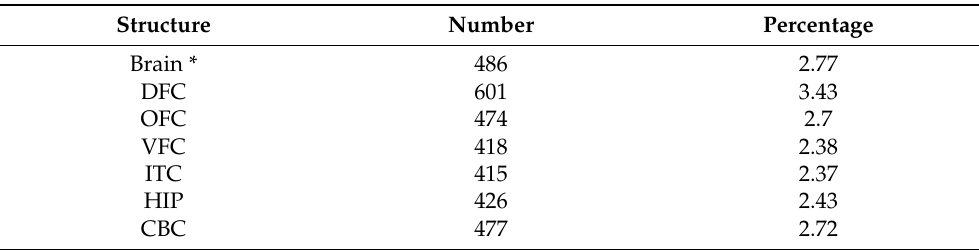
Table 2. Number and percentage of coding protein genes per brain structure which are over-expressed in Down syndrome patients.